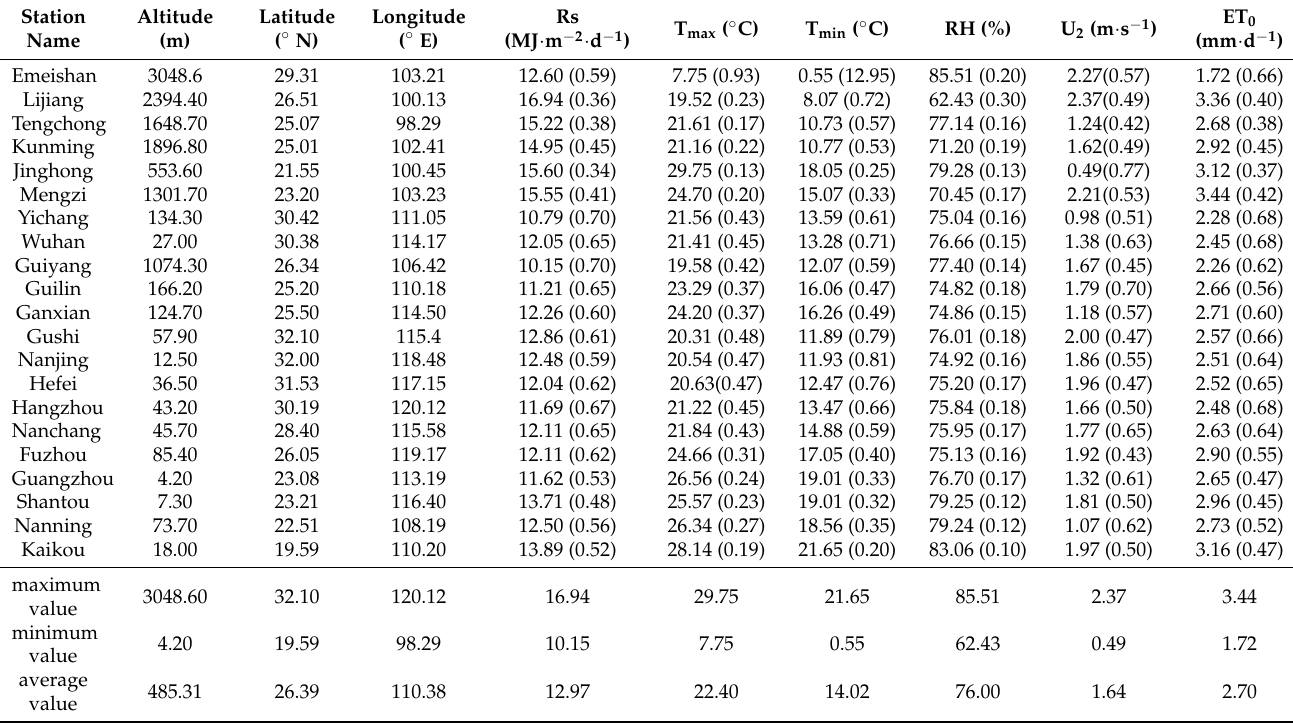
Table 1. The geographical locations and daily mean values of meteorological data for each of the twenty-one weather stations in the present